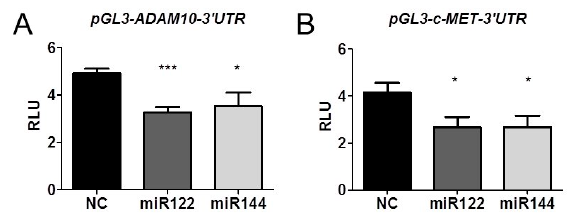
Figure 8. MiR122 and miR144 directly target the ADAM10 and c-Met 3’UTR. Co-transfection of miR122 or miR144 mimic with either pGL3-ADAM10-3’UTR ( A ) or pGL3-c-Met-3’UTR ( B ) reduces luciferase activity in 92.1 cells. Irrelevant control miR (NC) does not a ff ect luciferase activity of pGL3-c-Met-3’UTR or pGL3-ADAM10-3’UTR. RLU (Relative Light Units) are obtained normalizing Luciferase activity to Renilla. Data represent mean ± sem. Data are representative of three experiments (* p < 0.05; *** p <